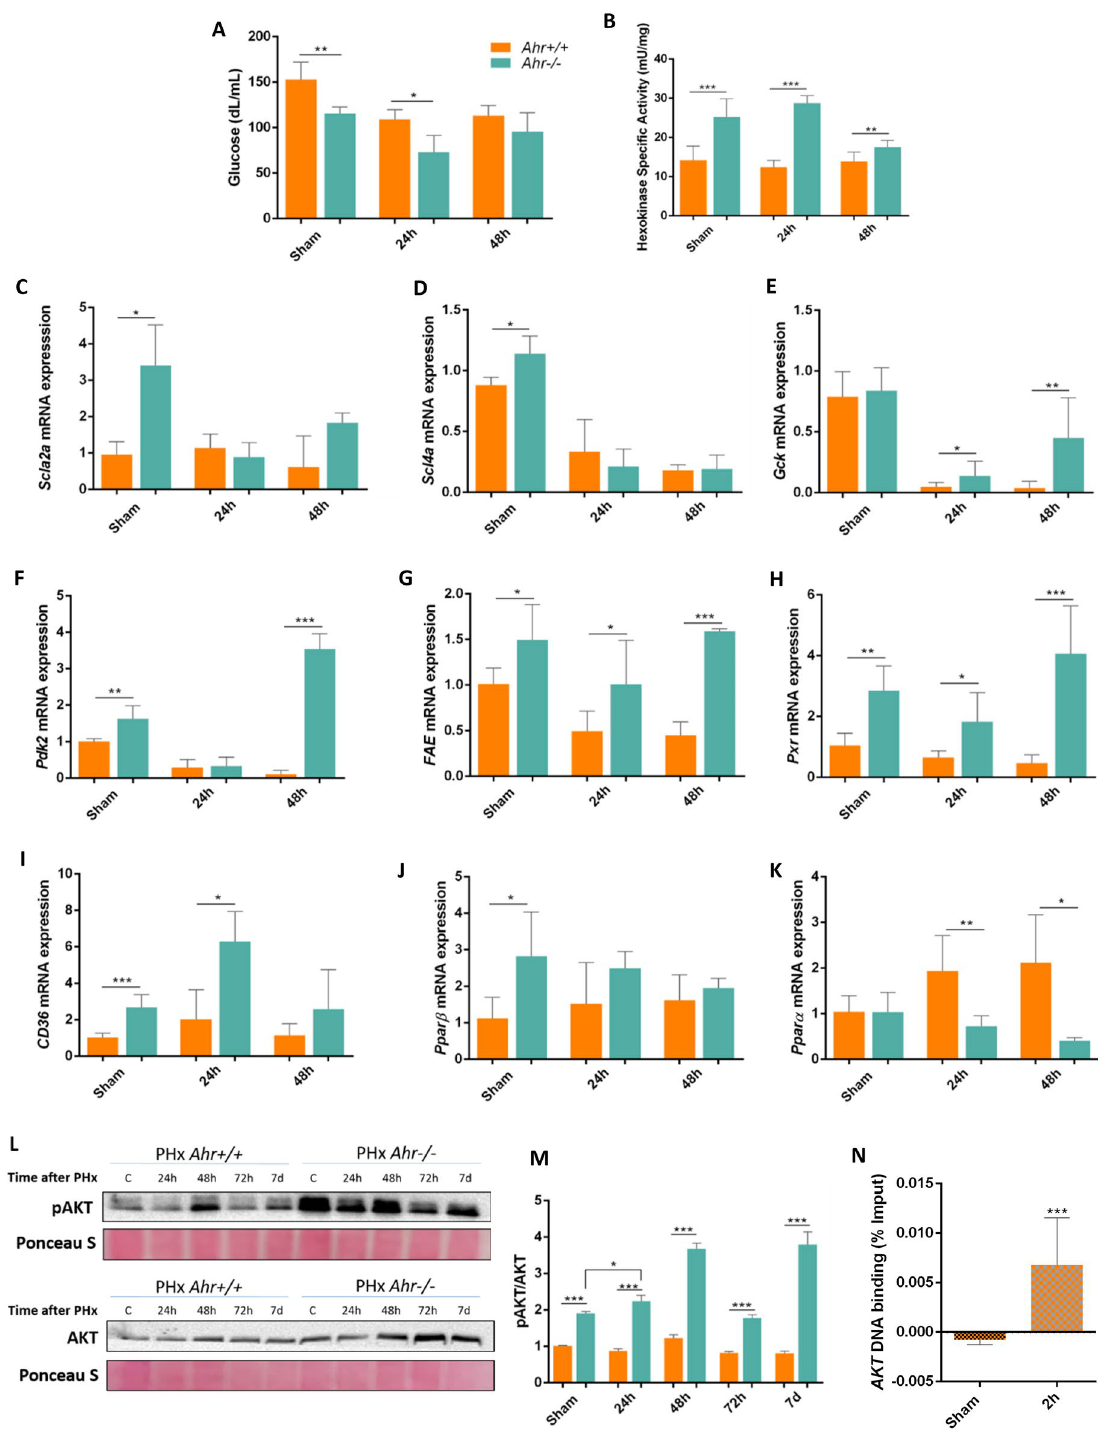
Figure 8. Metabolic profile during liver regeneration in absence of Ahr. ( A ) Blood glucose concentration in Ahr + / + and Ahr −/− mice at the indicated points after PHx was measured using a glucometer. ( B ) Hexokinase activity in liver homogenates under the same experimental conditions. mRNA expression for Slc2a2 ( C ), Scl2a4 ( D ), Gck ( E ), Pdk2 ( F ), Fae ( G ), Pxr ( H ), Cd36 ( I ), Pparb ( J ) and Pparα ( K ) was analyzed by RT-qPCR in liver extracts of Ahr + / + and Ahr −/− mice after PHx. Protein expression of Akt and p-Akt ( L ) was analyzed by immunoblotting and the p-Akt/Akt ratio quantified ( M ). Ahr binding to the XRE binding sites located in the Akt gene promoter was determined by chromatin immunoprecipitation (ChIP) under the same experimental conditions ( N ). qPCR was used to quantify changes in DNA binding and the results were normalized to the corresponding input DNAs. Gapdh was used to normalize target gene expression (ΔCt) and 2 −ΔΔCt to calculate changes in mRNA levels with respect to sham-surgery control mice. *p < 0.05, **p < 0.01, ***p < 0.001. Data are shown as mean ± SD. The experiments were performed using three mice per time point and three technical replicates were done. Ponceau staining was used to normalize protein